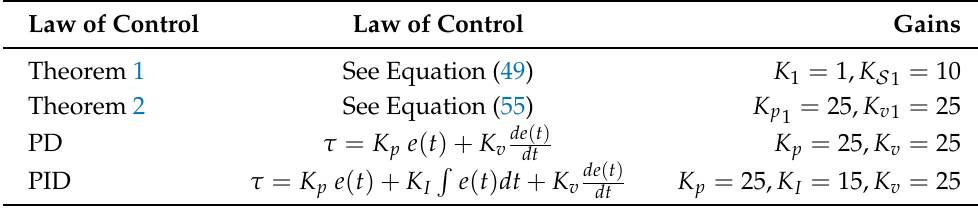
Table 2. Feedback controllers for the single degree-of-freedom robot.